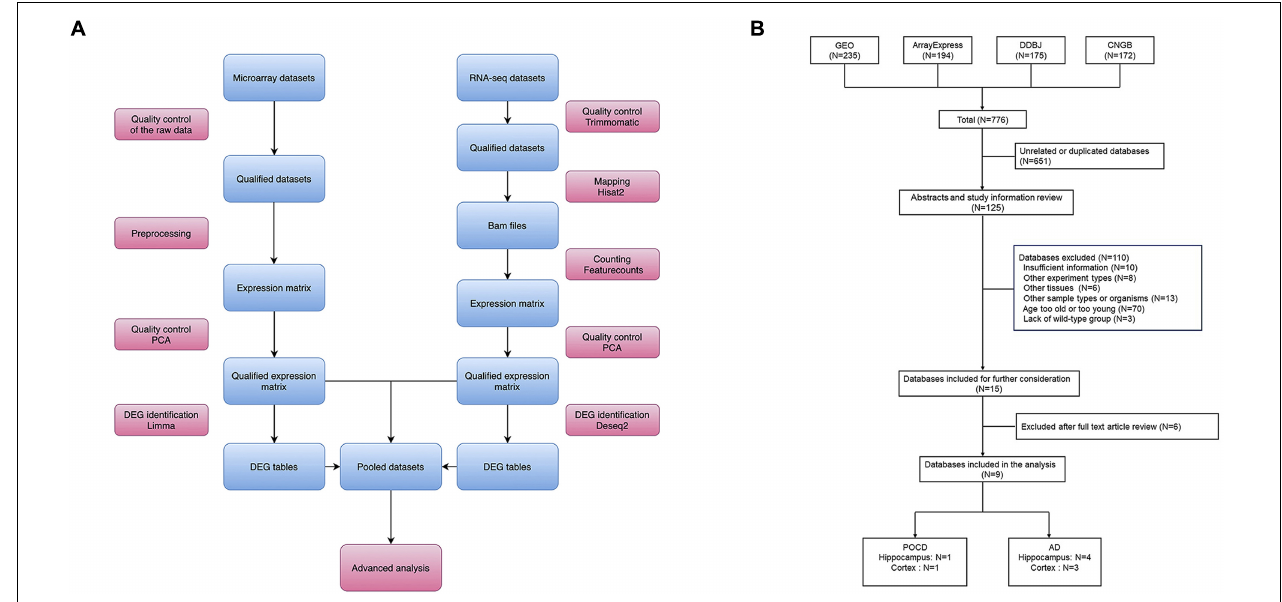
FIGURE 1 | (A) Overall study design and bioinformatics analysis workflow. (B) Flow diagram of dataset search and